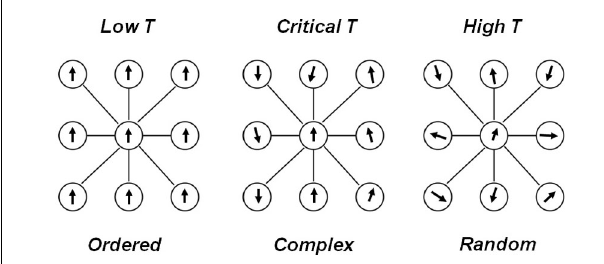
FIGURE 1 |A simple diagram of spins in the Ising model. (Left) At low temperature, nearest neighbor interactions dominate over thermal fluctuations. As a result, almost all the spins align in the same direction, producing a very ordered state. (Right) At high temperature, thermal fluctuations dominate over nearest neighbor interactions. As a result, the spins point in different directions, producing a very disordered state. (Center) At some critical temperature, nearest neighbor interactions and thermal fluctuations balance to produce a complex